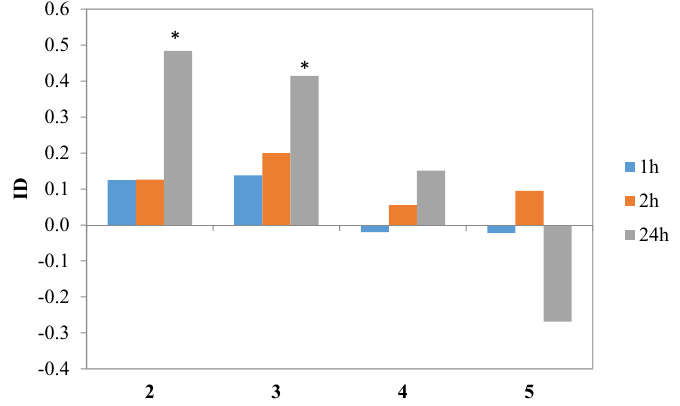
Figure 8. Effect of lactones 2 – 5 on settling preferences of Myzus persicae in the choice test. ID—index of deterrence, * p < 0.05 (Student t ‐ test).